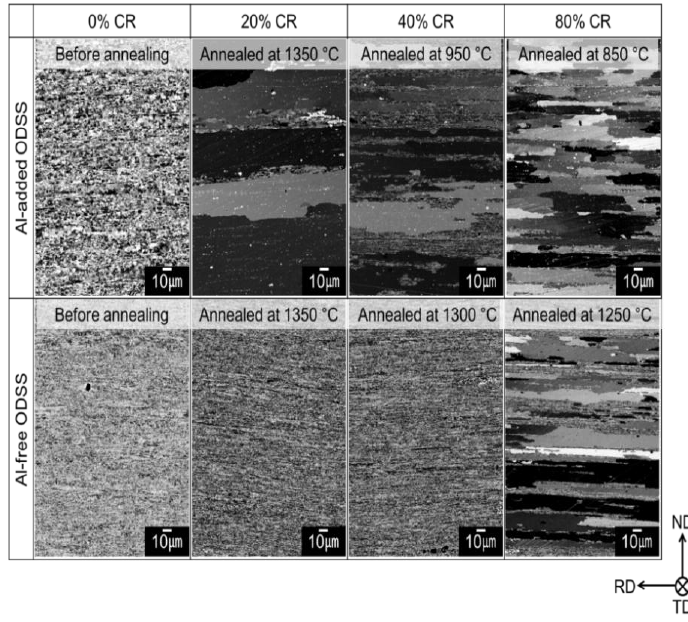
Figure 6. Grain morphology of Al-added and Al-free 15Cr-ODS ferritic steels after annealing at each temperature. In both the steels after annealing, the hardness is not changed among the specimens shown here. Cold rolling was performed before isothermal annealing.